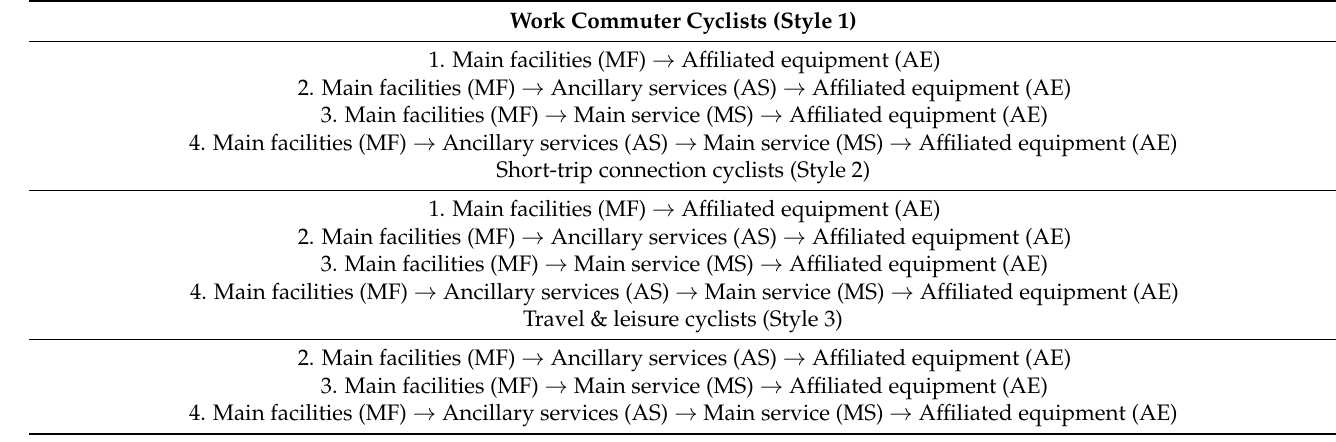
Table 23. The adoption paths for three styles of